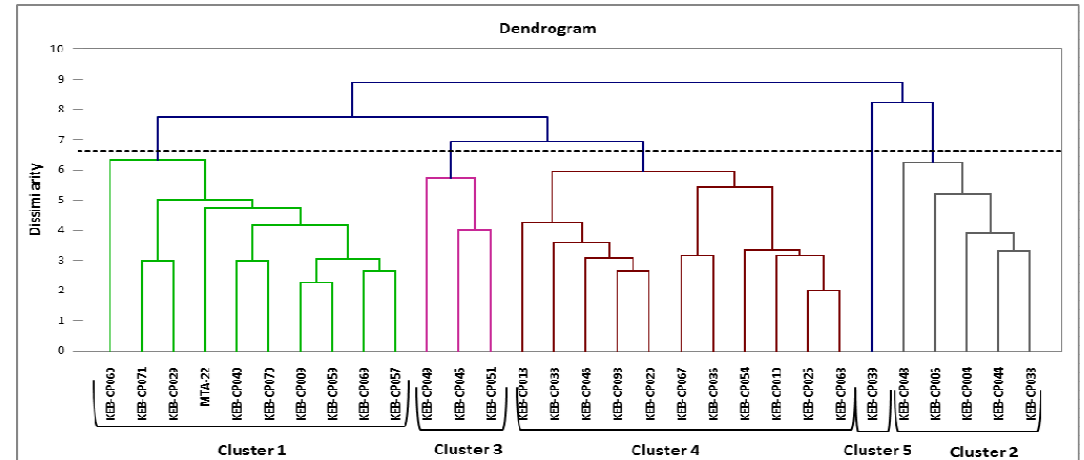
Fig. 2. Phylogenetic relationship between the thirty accessions of cultivated Vigna unguiculata from the Western Region of Cameroon Table 3. Accessions distribution between clusters based on 19 qualitative traits at cultivated Vigna unguiculata Cluster